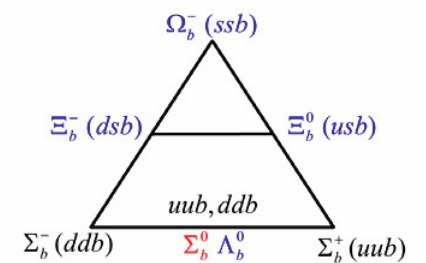
Figure 8. Ground-state b -baryons in a triangular arrangement. The isospin and the strangeness quantum numbers run on the horizontal and vertical axis respectively.